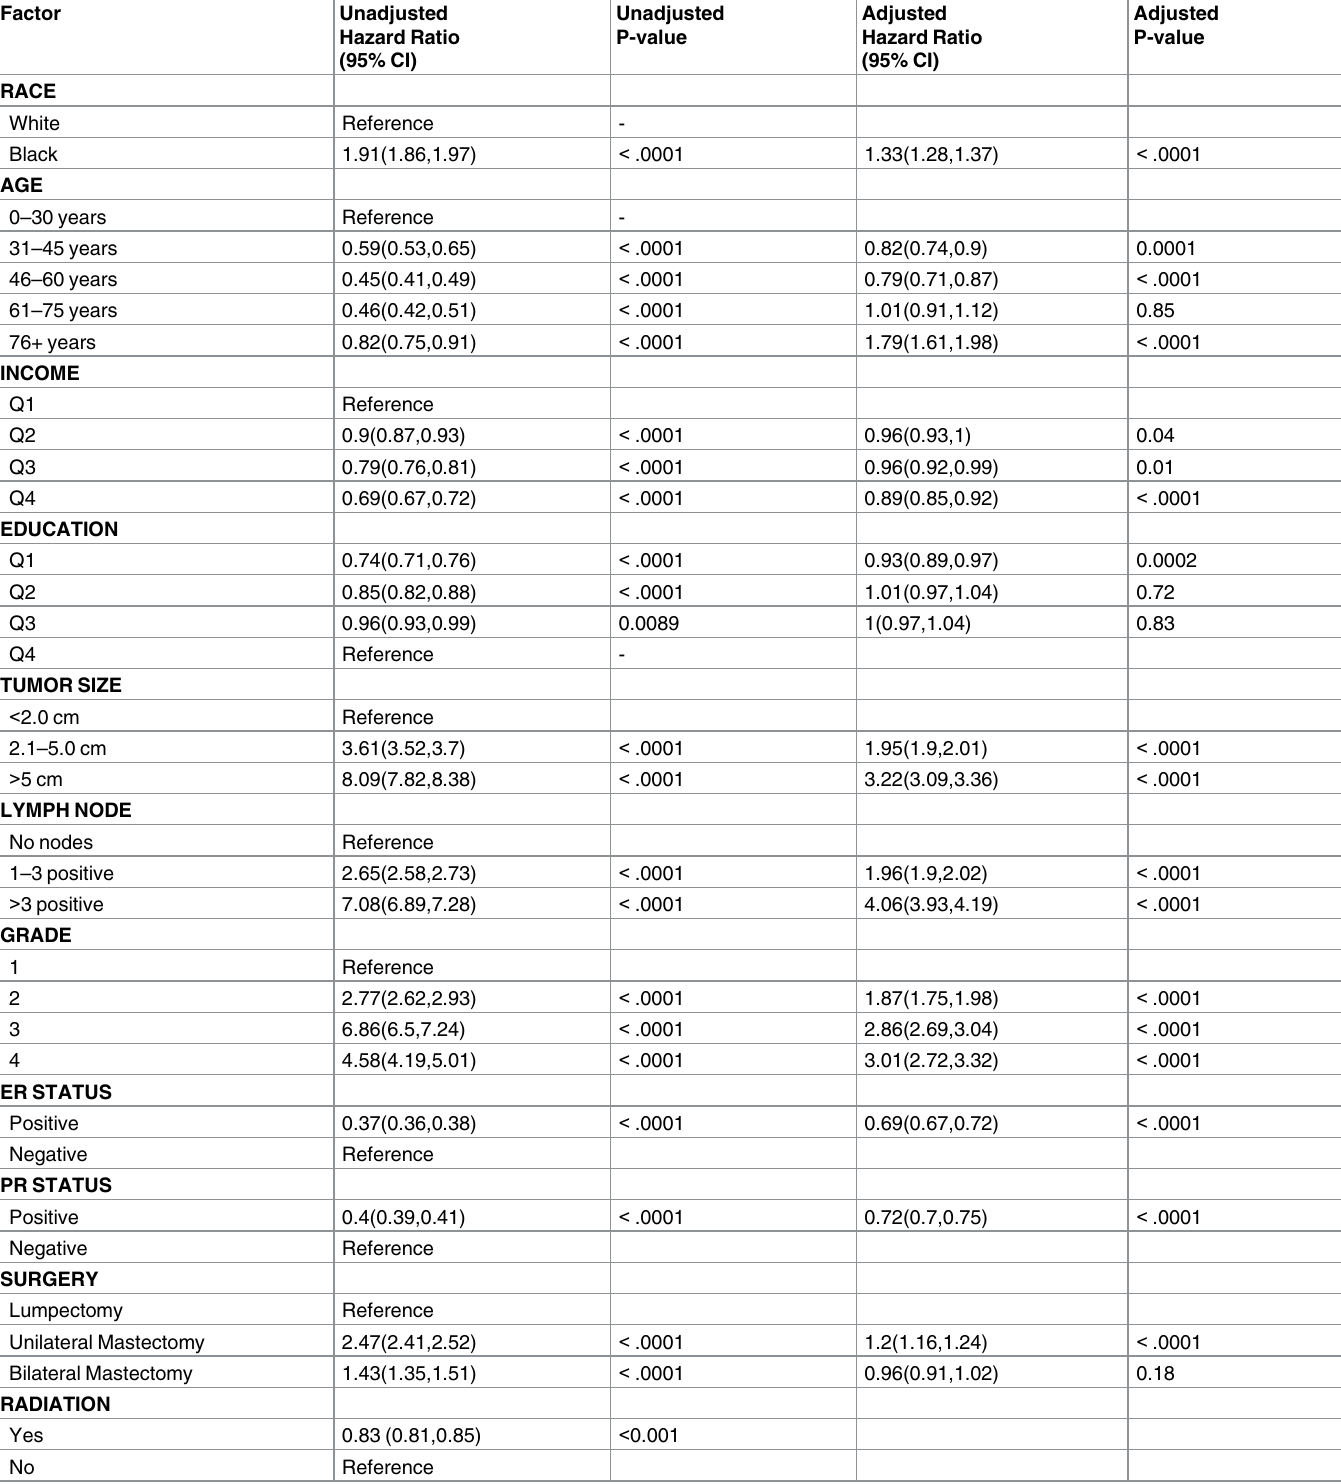
Table 2. Survival analysis of Black and White patients in a single